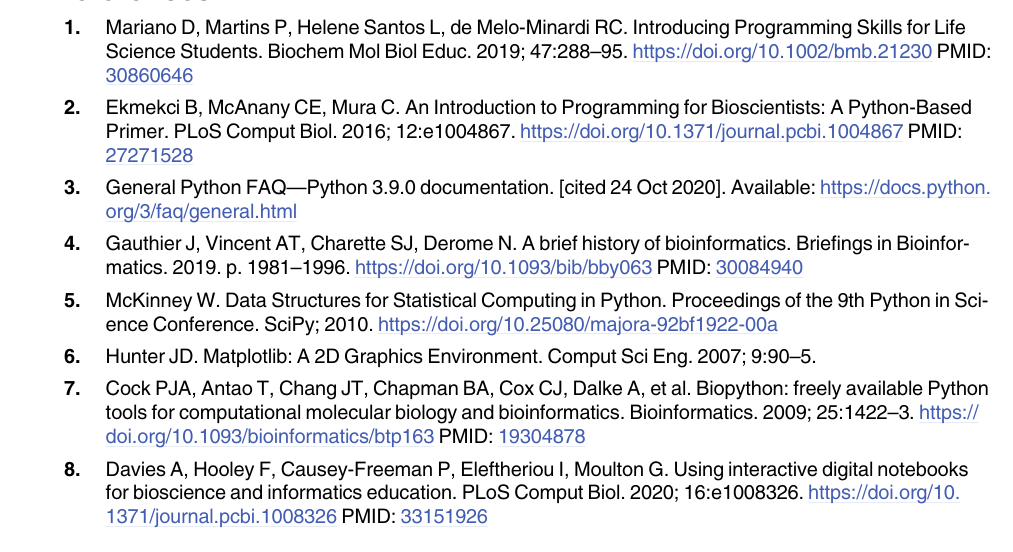
S4 Table. Questions addressed daily to students who attended the 3rd edition of the work- shop (2020). S5 Table. Questions addressed in the final evaluation survey to students who attended the 3rd edition of the workshop (2020). S6 Table. General information and statistics from the Brazilian Python Workshops for Biological Data over the years. (DOC) S1 Text. Need for bioinformatics training in Brazil and Latin America. S2 Text. A summary of the Brazilian Python Workshops for Biological Data. S3 Text. Final remarks about the virtual workshop during the COVID-19 pandemic and main takeaways. COVID-19, Coronavirus Disease